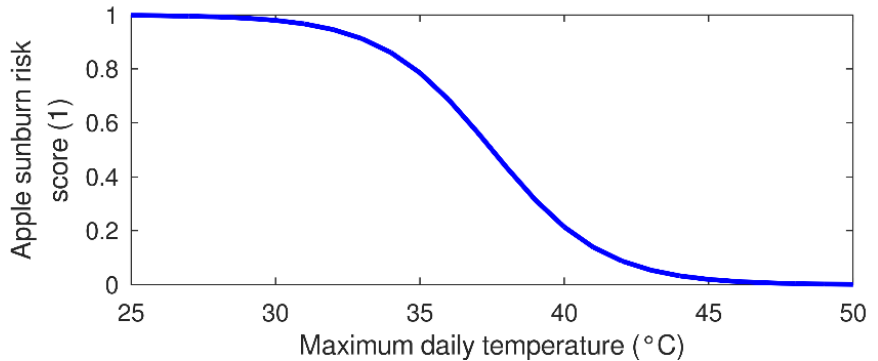
Figure 5 . Sunburn survival score for apple as a function of maximum temperature. A higher score indicates less sunburn risk.